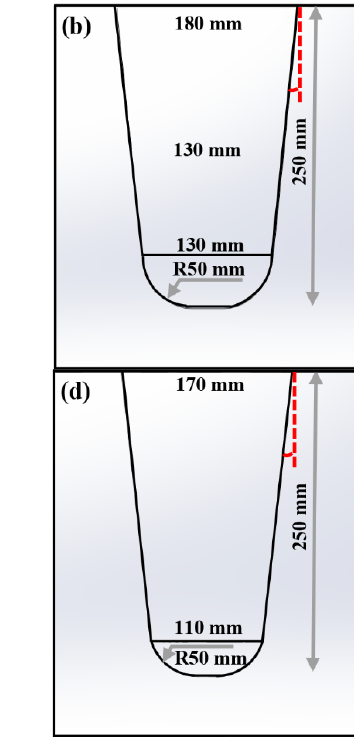
Figure 1. Mold design: ( a ) mold I; ( b ) mold II; ( c ) mold III; ( d ) mold IV.